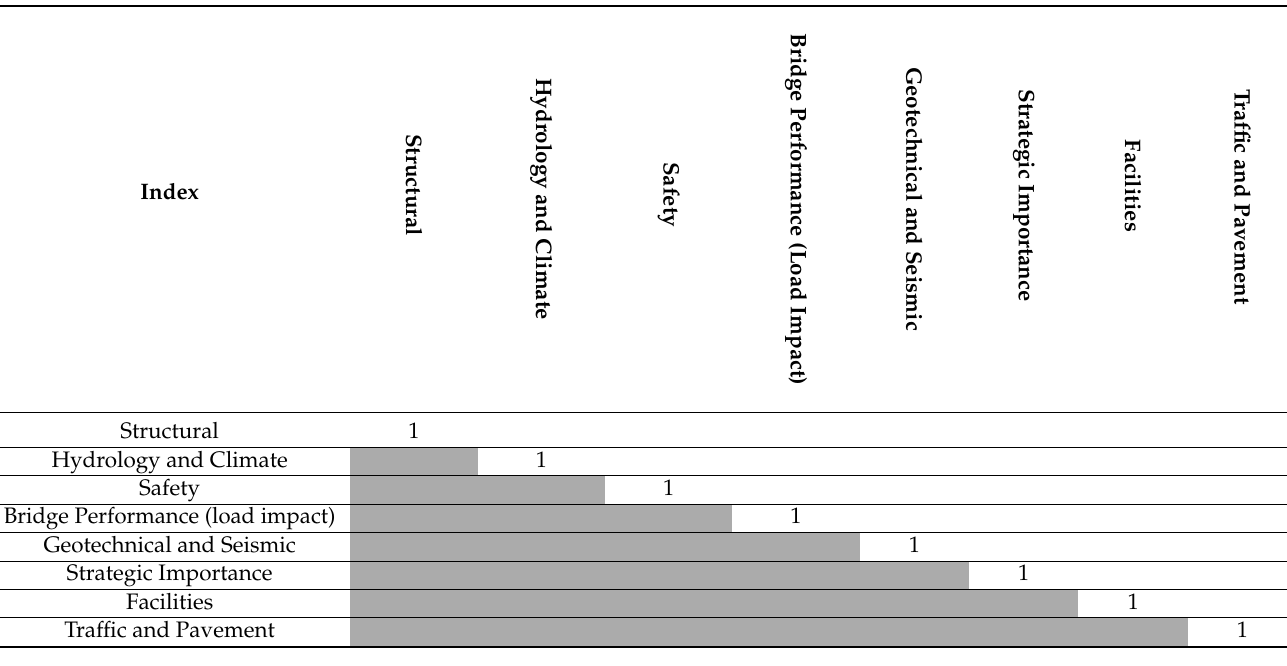
Table A1. Relative importance of